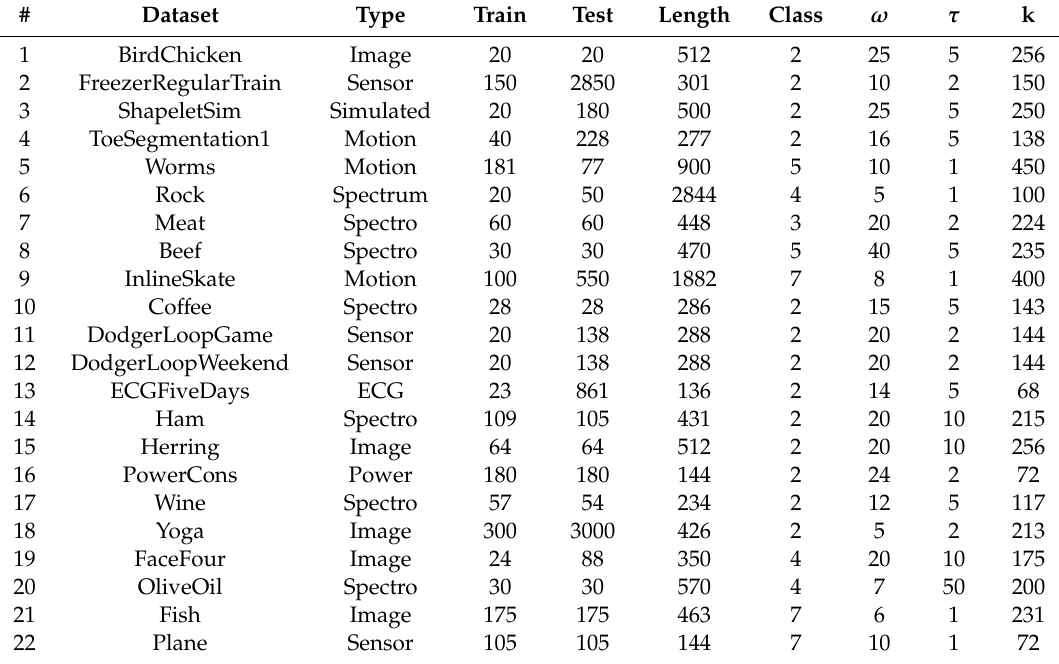
Table 1. Summary of data sets and the combination of parameters in the